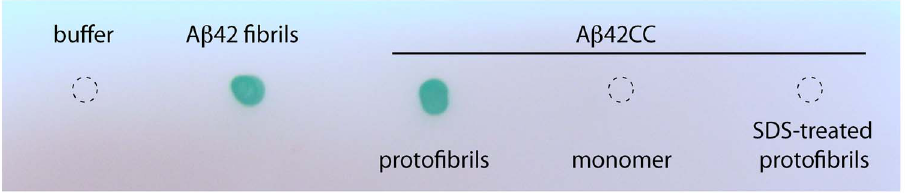
Figure 5. OC serum dot blot. The fibril specific OC serum recognizes A b 42 CC protofibrils and wild type A b 42 fibrils, but not monomeric A b 42 CC or protofibrils that have been denatured by boiling in SDS.